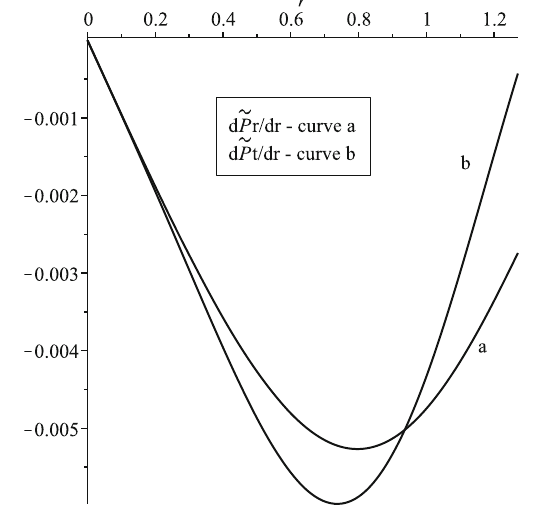
Fig. 17 Dominant energy condition for the solution obtained with the second algorithm with ˜ F = 0 from the isotropic Gold III solution